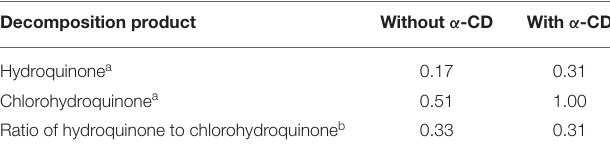
TABLE 4 | Summary of the formation of hydroquinone and chlorohydroquinone from chlorine dioxide mediated decomposition of BPA in real-world wastewater samples, measured as normalized integrated peak emissions from